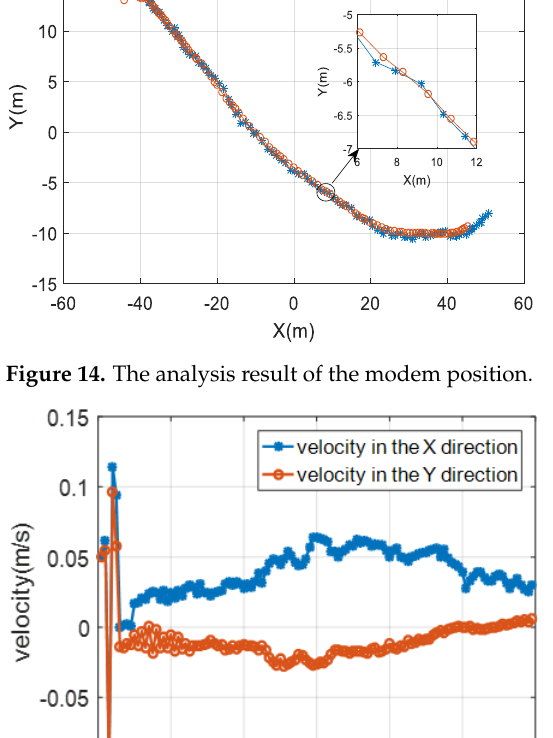
Figure 13. The drifting track of four buoy beacons. ( a ) The drifting track of the buoy 1; ( b ) the drifting track of the buoy 2; ( c ) the drifting track of the buoy 3; ( d ) the drifting track of the buoy 4. Figure 14 is the result of the modem position of the buoy 3. The blue line with ∗ in the figure is the GPS measurement result, and the red line with O is the position of the buoy modem after spatial position calibration. It can be seen that the compensated modem position lags a certain distance behind the buoy drifting trajectory. Figure 15 shows the results of the drifting speed of the buoy 3. Due to the influence of the anchor block, the drifting speed is relatively low.